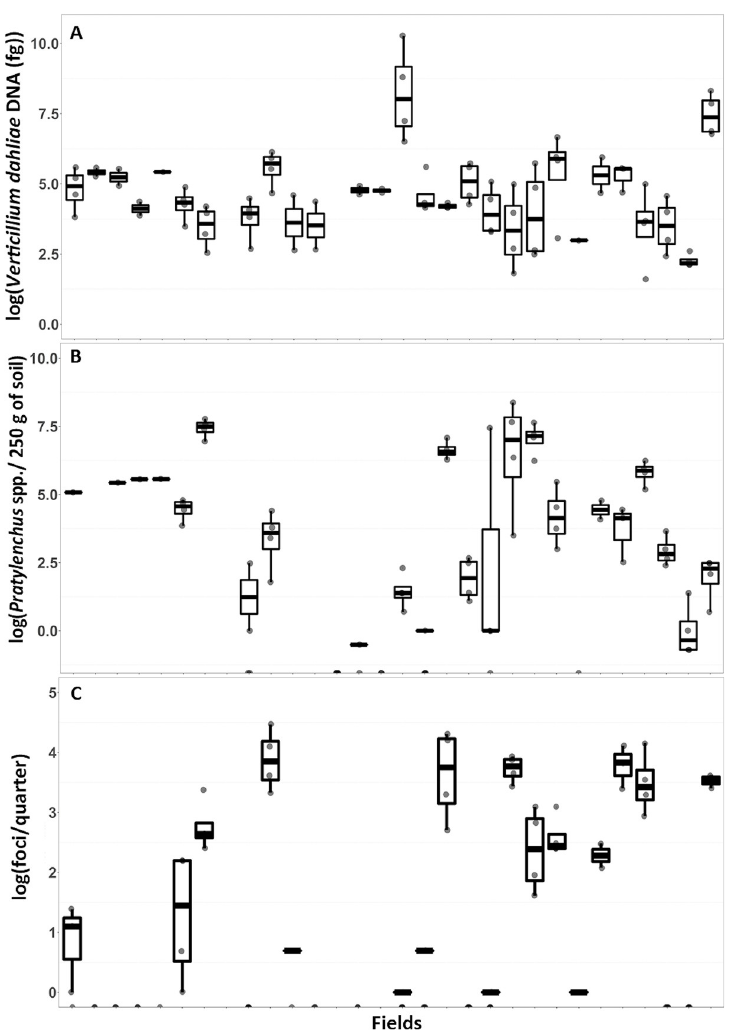
Fig 2. Wilt symptoms and pathogen abundance. Boxplots (minimum, first quartile, median, third quartile, and maximum) of (A) Verticillium dahliae inoculum, (B) counts of Pratylenchus spp. nematodes, (C) and Verticillium wilt symptoms quantified from commercial mint fields in Washington and Oregon